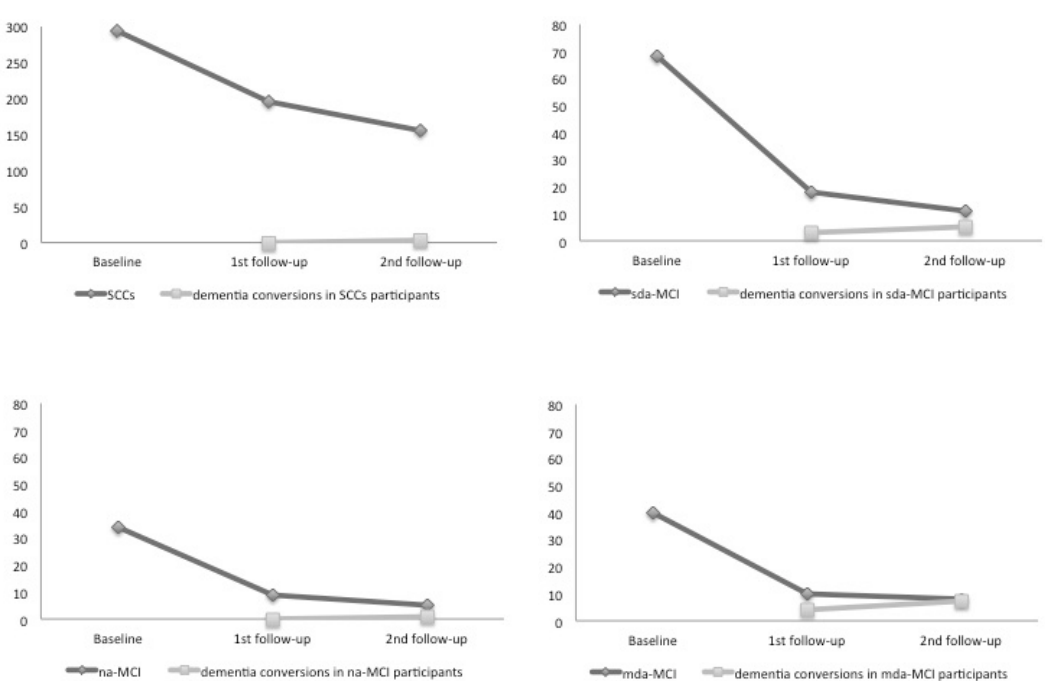
Figure 3. The number of participants whose diagnosis did not change at the follow-up assessments, and the number of participants who converted to dementia. SCCs = Subjective cognitive complaints; MCI = mild cognitive impairment; mda = multi-domain amnestic; na = non-amnestic; sda = single domain